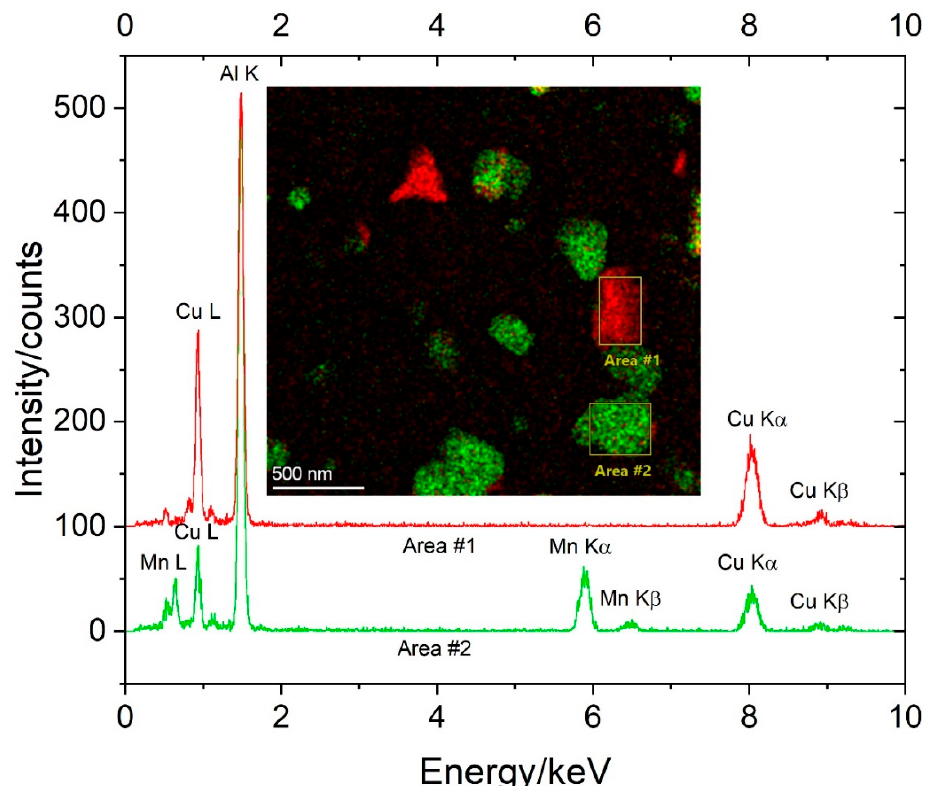
Figure 10. EDS analysis of two particles in the NZ in areas #1 and #2. Inset is the elemental maps of Cu and Mn.